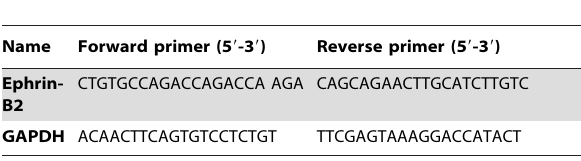
Table 1. Primer pairs used in the